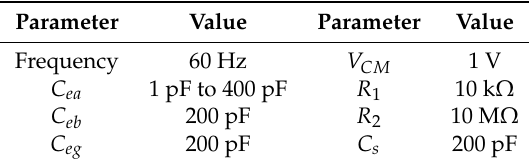
Figure 4. CM equivalent circuit without the DTCs. Table 1. Parameters of circuit components in Figure